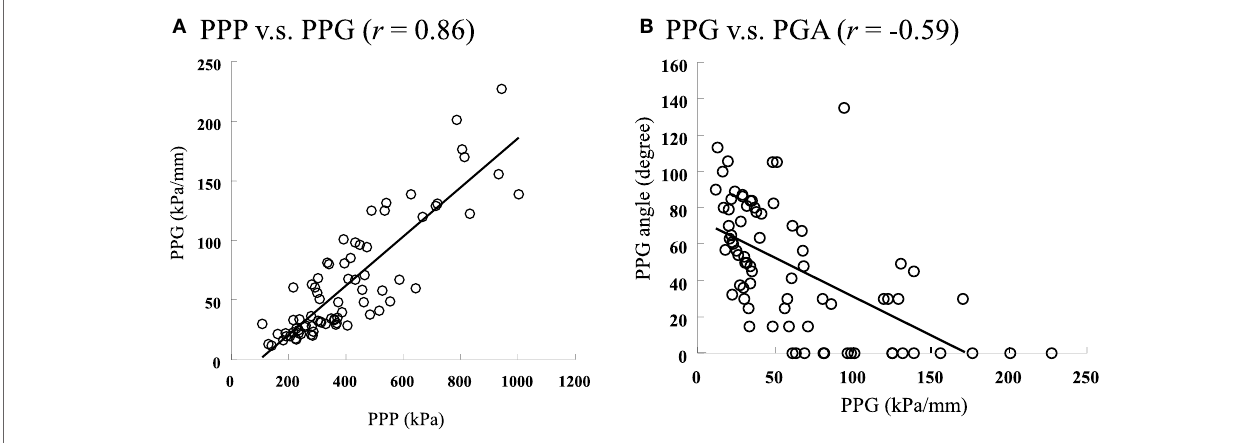
FigUre 4 | The scatter plots to show the relationships among the PPP, PPg, and Pga in diabetics . (a) The relationship between PPP and PPG, PPP vs. PPG ( r = 0.86). (B) The relationship between PPG and PGA, PPG vs. PGA ( r = −